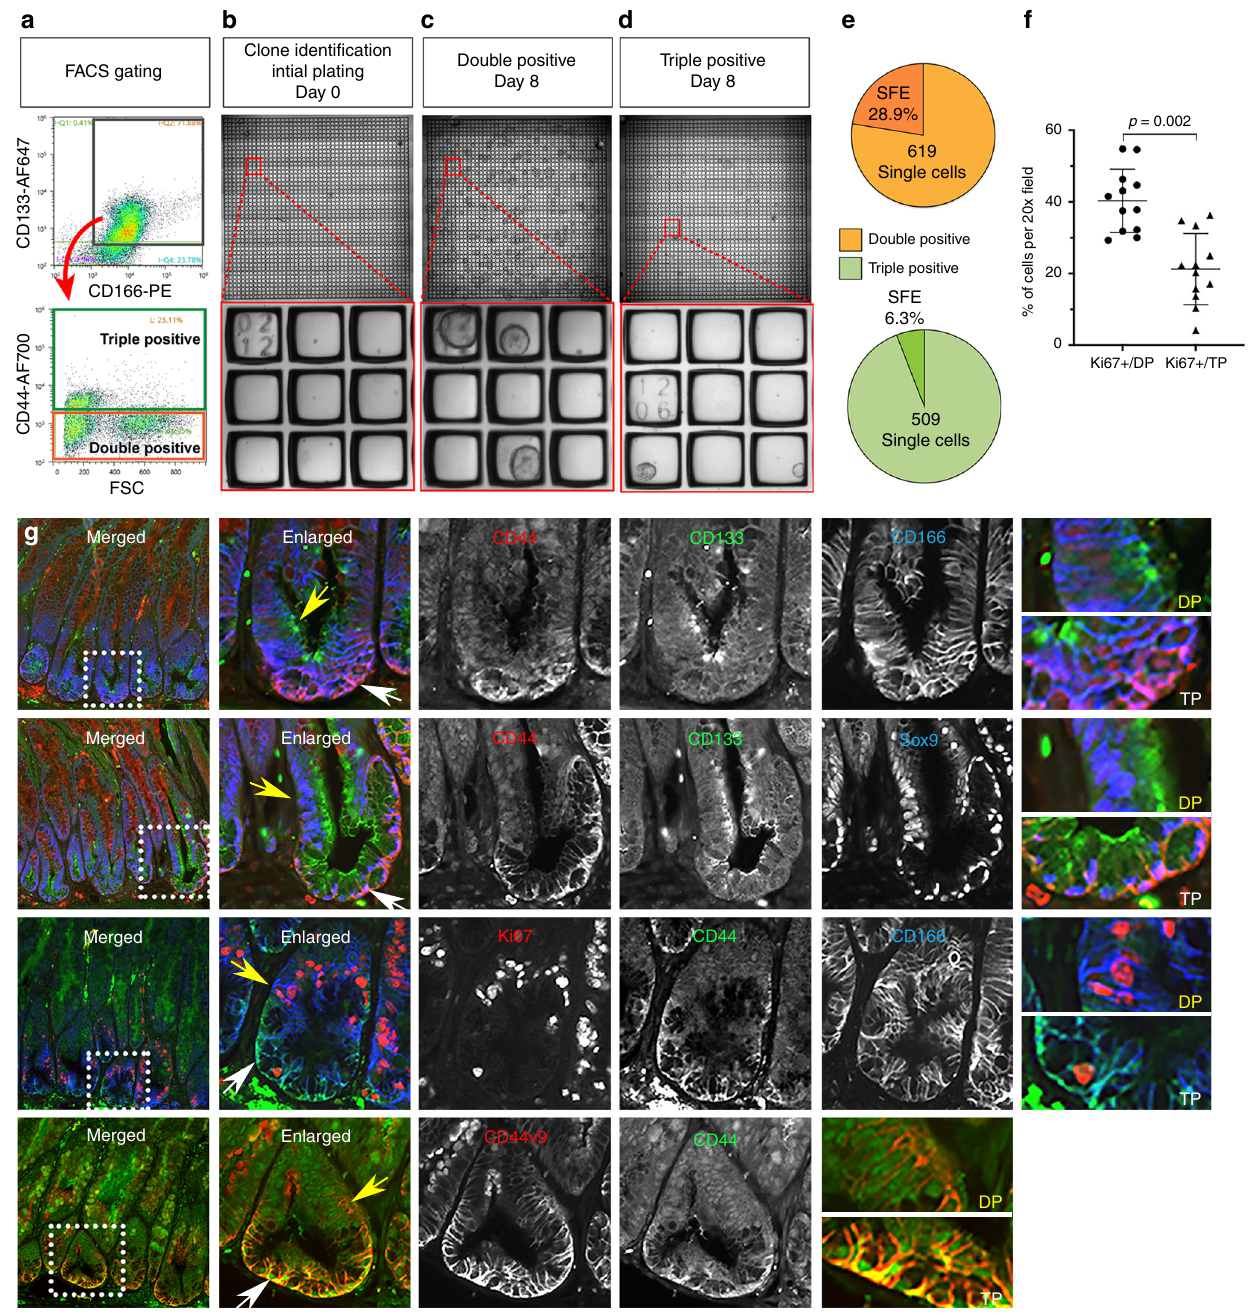
Fig. 8 Identi fi cation of dysplastic stem cells in Meta4. a – e Clonal sphere forming ef fi ciency from Meta4 subpopulations. a Meta4 organoids were dissociated to single cells, stained for CD44, CD133, CD166, and FACS isolated. Following doublet-discrimination and dead cell exclusion, CD133/CD166 positive cells (gray gate) were applied (red arrow) to a CD44 positive gate to distinguish between double-positive CD44neg/CD133 + /CD166 + (orange gate) and triple-positive CD44 + /CD133 + /CD166 + cells (green gate). Double-positive and Triple-positive cells were collected by FACS and applied to CRAs. b Immediately after plating, single cells were quanti fi ed and their physical address on the CRA was determined. c , d After 8 days of culture, spheres were quanti fi ed and their physical address on the CRA was determined. Upper-panels are low magni fi cation of each CRA containing 2025 wells. Red-boxes indicate the regions in the higher magni fi cation images depicted in the lower panels. e Spheres-Forming Ef fi ciency (SFE) of clonal events was determined by quantifying the number of spheres that developed from all single cell events at t = 0. There were 619 Double-positive clonal events identi fi ed in the CRAs, and 28.9% of those generated spheres (orange chart). There were 509 Triple-positive clonal events identi fi ed in the CRAs, and 6.3% of those generated spheres (green chart). The data represent binary outcomes. f Quantitation of immuno fl uorescence staining of Ki67-positive cells in either Double-positive (DP) or Triple-positive (TP) cell zone in Mist1-Kras mouse stomach corpus at 4 months after tamoxifen injection. Data are presented as mean values with standard deviation ( n = 12). P -values were calculated using paired two-tailed t -test. g Immunostaining for CSC markers, CD44 (basolateral membrane), CD133 (apical membrane) and CD166 (basolateral membrane), metaplasia and gastric cancer markers, Sox9 and CD44v9, and a proliferation marker, Ki67 in Mist1-Kras mice at 4 months after tamoxifen injection. Yellow arrow indicates Double-positive (DP) cells and white arrow indicates Triple-positive (TP) cells. Dotted boxes indicate enlarged area. Scale bars indicate 100 μ m. Source data are provided as a Source Data fi